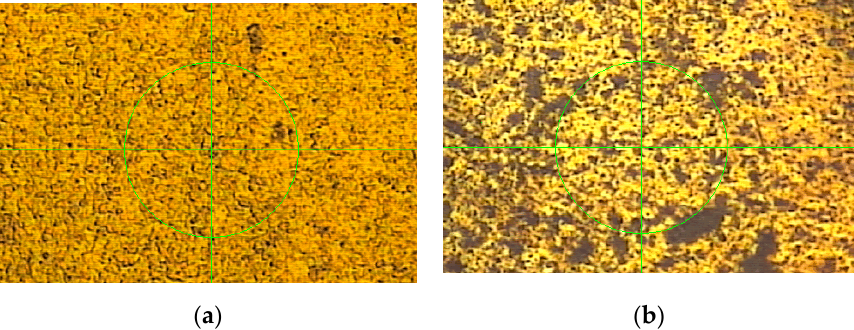
Figure 11. Images of surfaces of the PCB electrode ( a ) and AC2P electrode ( b ) discussed in the next section. The diameter of the green cursor circle is 150 µ m.